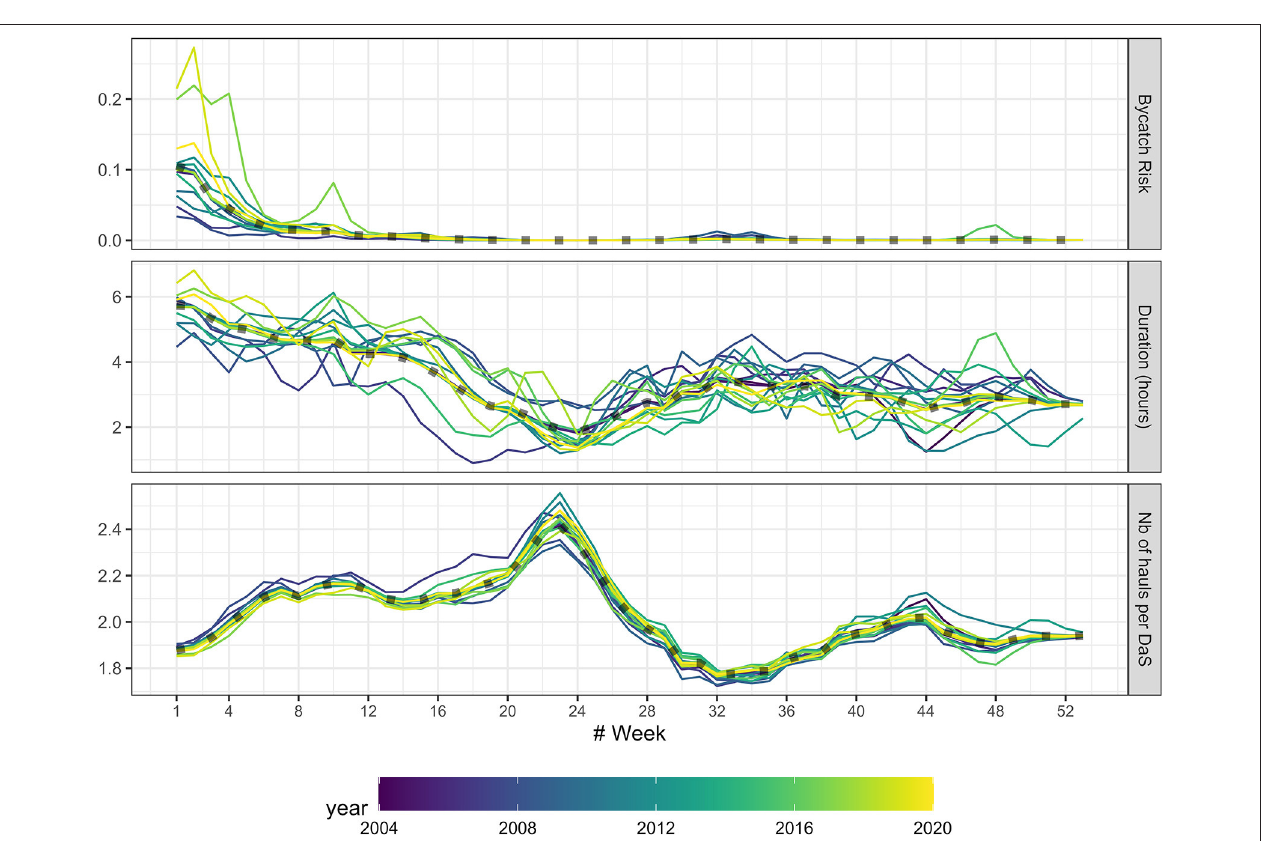
FIGURE 3 | Model-based estimates (posterior medians) of bycatch risk, haul duration, and number of hauls per Days at Sea (DaS) of pair-trawlers (PTM) flying the French flag operating in the study area. Each colour represents a different year (parameters α jkt in Equation 4) and the dotted black line the yearly average (parameters ǫ t in Equation